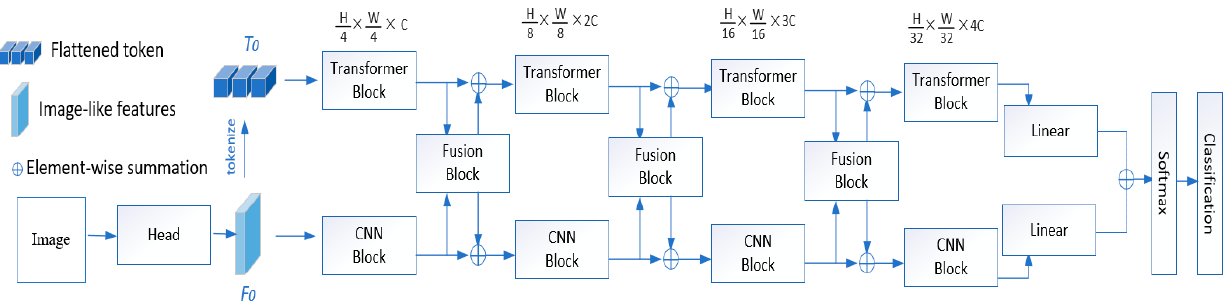
Figure 4. Overall flow of ShuFormer.